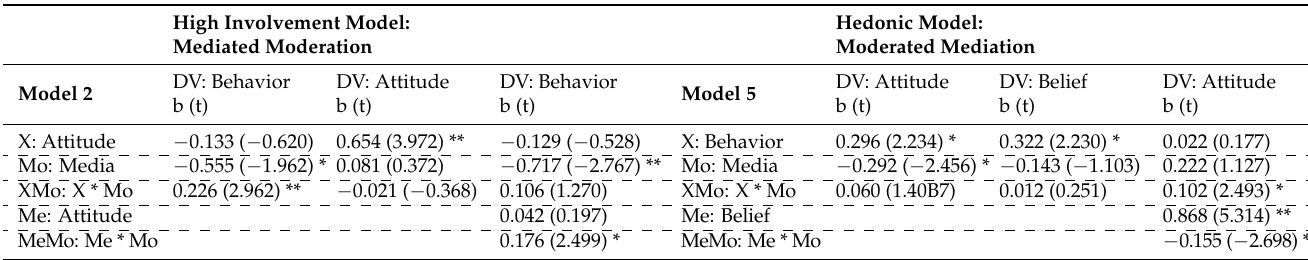
Table 7. Media Trust Model in